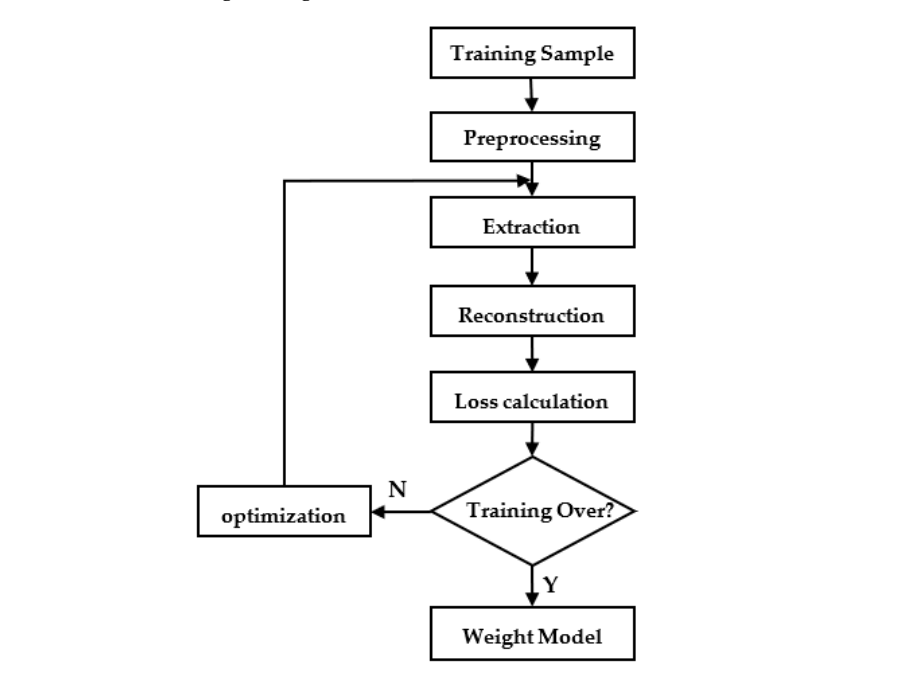
Figure 3. Model training algorithm flow.